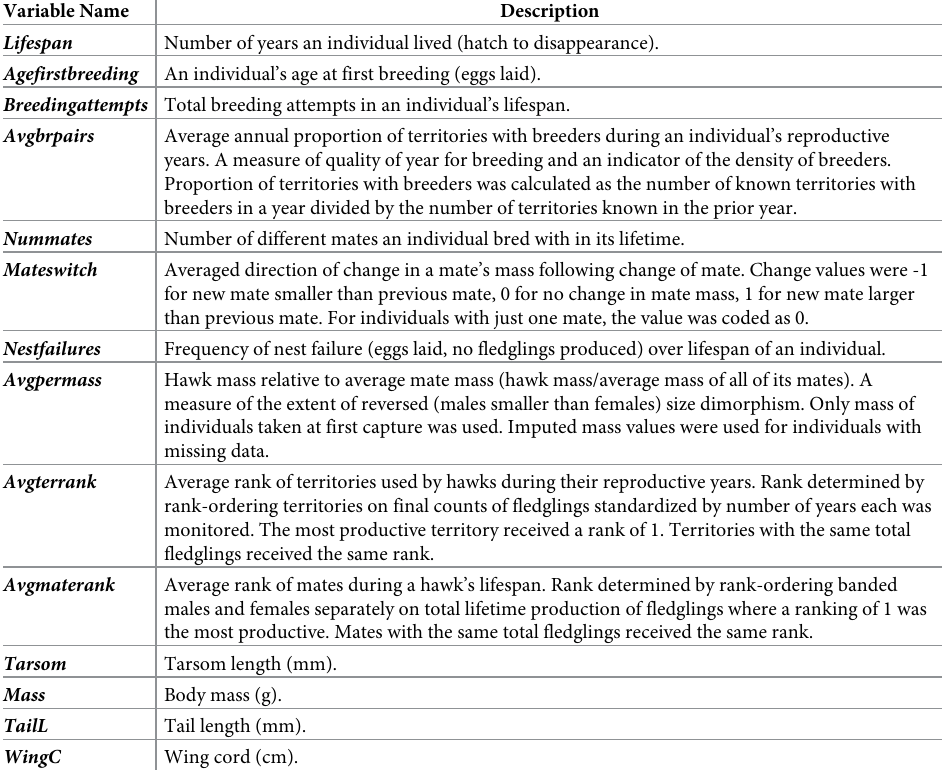
Table 1. Explanatory variables for individual and environmental effects on lifetime reproduction (LR) of north- ern goshawks in Arizona, USA. Table includes variable name and variable description for generalized linear